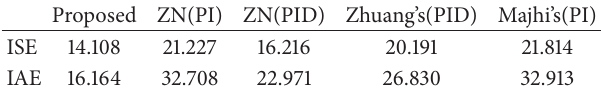
Table 4: The ISE and IAE of five methods for Example